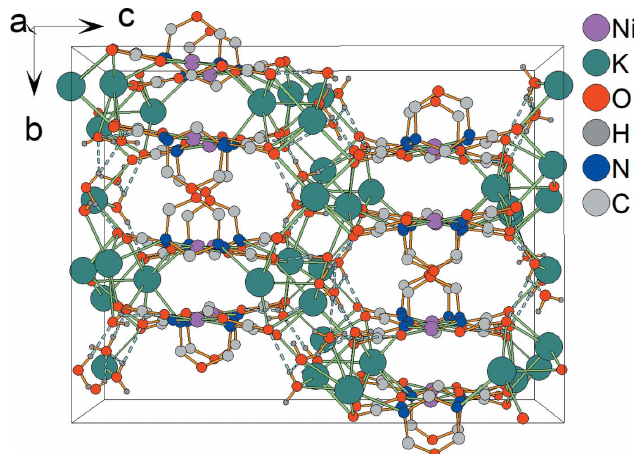
Figure 6 Figure 7 Polyhedral views of the coordination environments for the potassium Crystal packing of the title compound. Hydrogen bonds are indicated by cations; the minor disordered components of atoms K3 and K4 (K3 A and dashed lines. H atoms of the C—H groups and minor disordered K4 B ) are omitted for clarity. [Symmetry codes: (i) x (cid:3) 1 , (cid:3) y + 1 , (cid:3) z + 1; 2 2 components (K3 A and K4 B , O4 WB water molecule) are omitted for (ii) (cid:3) x + 1, (cid:3) y , (cid:3) z + 1; (iii) x (cid:3) 1 , y , (cid:3) z + 1 ; (iv) x + 1 , y , (cid:3) z + 1 ; (v) (cid:3) x + 3 , 2 2 2 2 2 clarity. (cid:3) y , z (cid:3) 1 ; (vi) x , (cid:3) y + 1 , z + 1 ]. 2 2 2